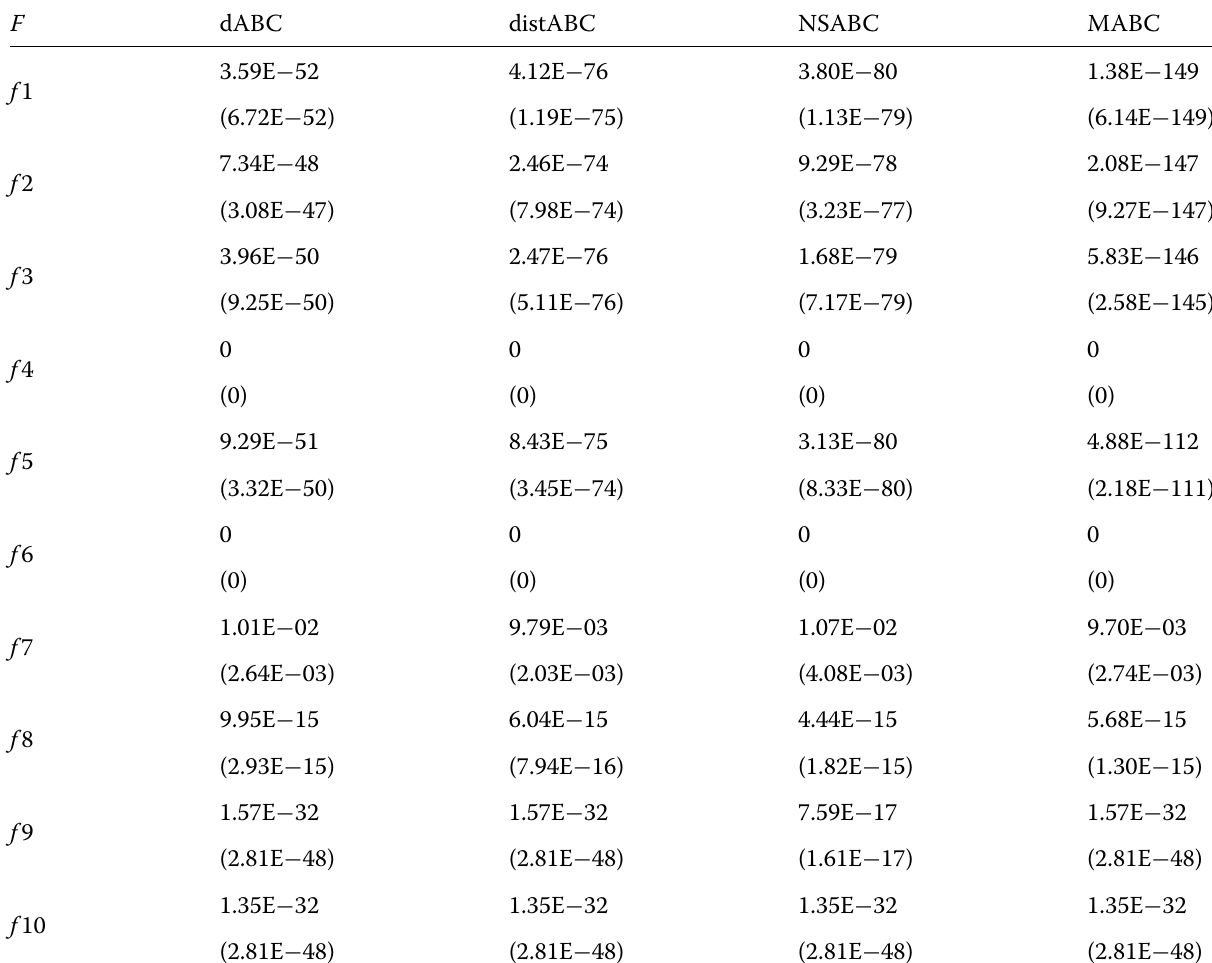
Table 4 Comparison results (2), D =